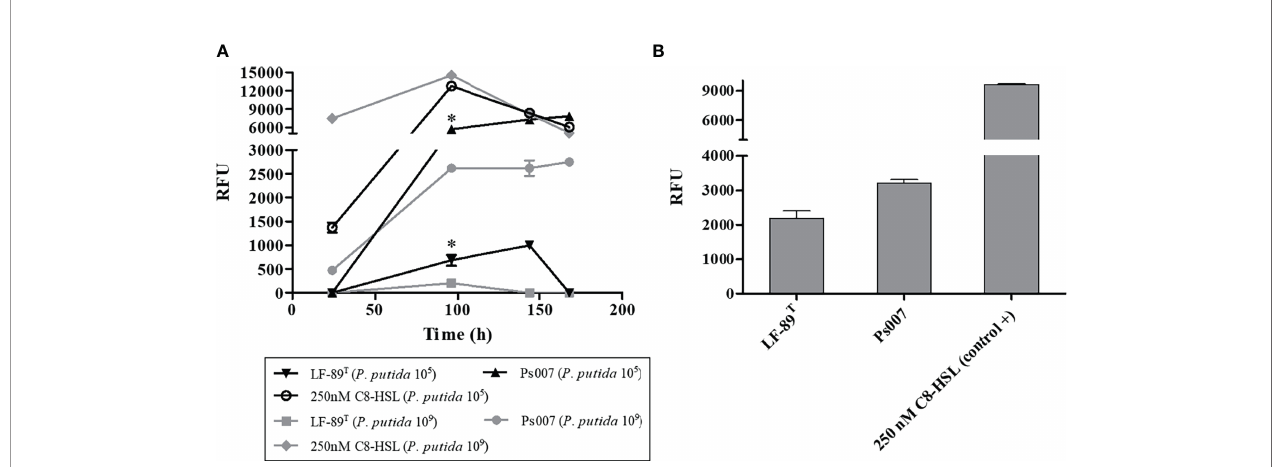
FIGURE 2 | Fluorescence induction in P. putida EL 106 (RPL4cep) in co-culture with P. salmonis LF-89 T and EM-90-like (Ps007) strains. (A) P. putida EL 106 (RPL4cep) 10 5 cell/mL and 10 9 cell/mL at 24, 96, 144 and 168h. Asterisks indicate statistical signi fi cance (ANOVA P ≤ 0.01, n = 3) in P. salmonis Ps007 strain between 10 5 and 10 9 cells/mL of the biosensor strain from 96 h to 168 h. In P. salmonis LF-89 strain asterisks indicate statistical signi fi cance (ANOVA P ≤ 0.01, n = 3) between 10 5 and 10 9 cells/mL of the biosensor strain only at 96 h. (B) P. putida EL 106 (RPL4cep) 10 5 cell/mL at 120 h. Control: P. putida EL106 (RPL4cep) + 250 nM C8-HSL. Emitted fl uorescence was recorded in a microtiter plate reader at 515 nm. RFU, relative fl uorescence units. Asterisks indicate statistical signi fi cance (ANOVA P ≤ 0.01, n = 3) with the control. Error bars: standard deviation.